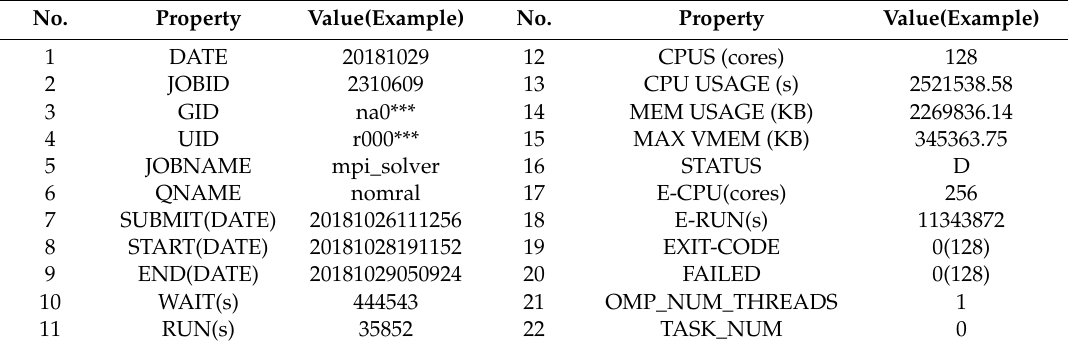
Table 2. Job executed information of the converted Sun Grid Engine (SGE)